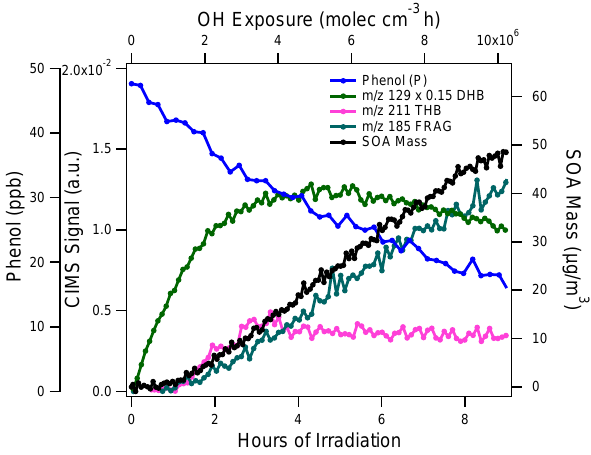
Fig. 2. Phenol low-NO x gas-phase and particle-phase development. The signal at m/z 129 was scaled by a factor of